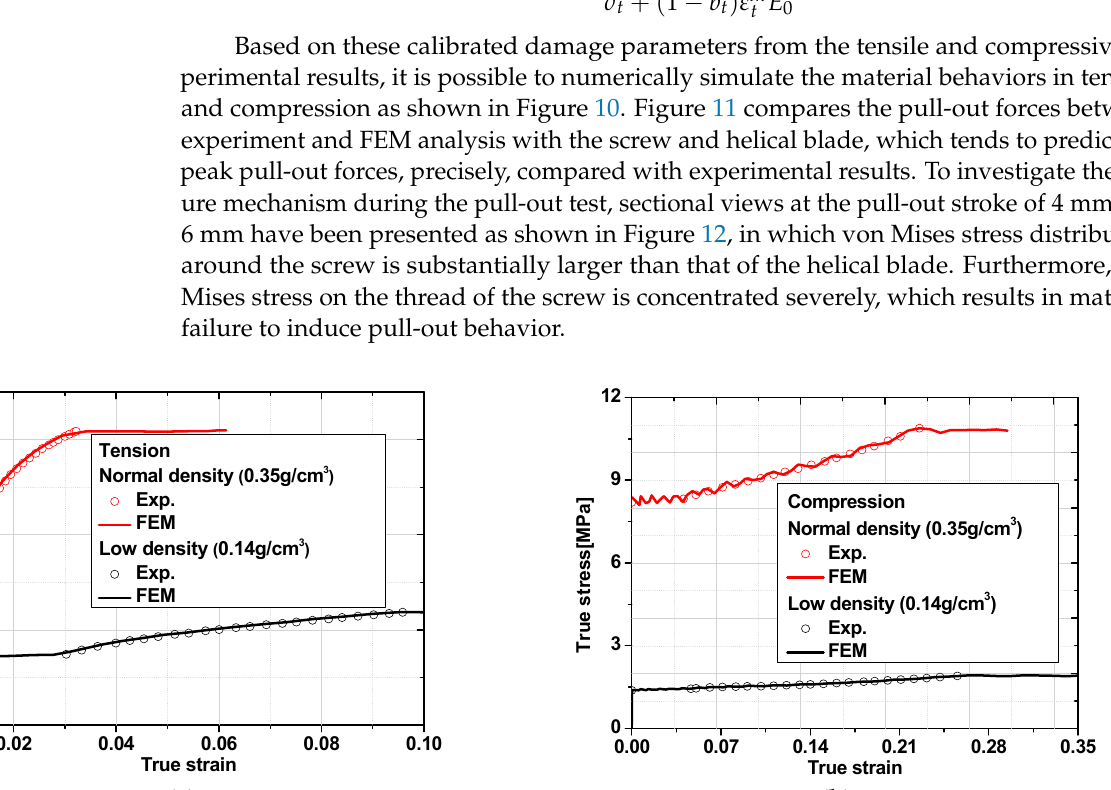
, which is expressed in t